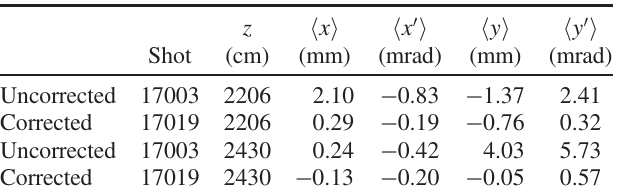
TABLE III. Measured beam centroid corrections at the end of the accelerator BPM19 ( z ¼ 34 . 3 m) and BPM20 ( z ¼ 36 . 1 m) using dipoles 57 ð x; y Þ and 60 ð x; y Þ